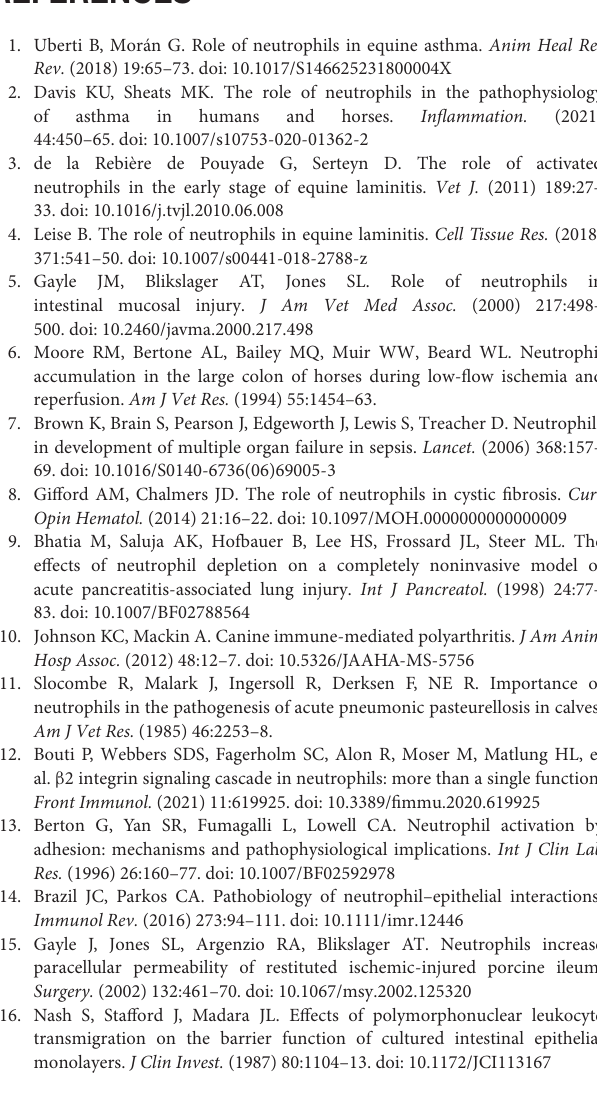
Supplementary Figure S5 | Withaferin A does not cause rapid neutrophil cell death. Mean (SEM) percentage of dead neutrophils relative to media control, unprimed neutrophils following 2-h treatment of equine neutrophils under GM-CSF-primed ( n = 3 horses) or unprimed ( n = 4 horses) conditions. Flow cytometry quantification of annexin V binding and propidium iodide staining. Paired t -test of media control neutrophils; no significant difference between GM-CSF-primed and unprimed media control neutrophils. One-way repeated measures ANOVA (Holm-Sidak multiple comparison testing); no significant difference between treatments and media control within same priming condition. Supplementary Figure S6 | Higher concentrations of Withaferin A decrease neutrophil viability and increase neutrophil death by 24h. Mean (SEM) percentage of live (A) and dead (B) neutrophils relative to media control, unprimed neutrophils following 24-h treatment of equine neutrophils under GM-CSF-primed or unprimed ( n = 6 horses) conditions. Flow cytometry quantification of annexin V binding and propidium iodide staining. Paired t -test of media control neutrophils; # p < 0.05, #### p < 0.0001 compared to unprimed media control. One-way repeated measures ANOVA (Holm-Sidak multiple comparison testing); ∗ p < 0.05, ∗∗ p < 0.01, ∗∗∗ p < 0.001 compared to media control within same priming